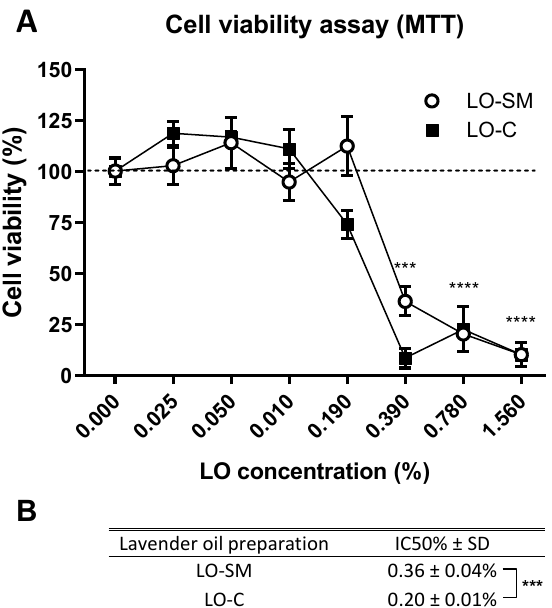
Figure 2. Cytotoxicity of tested lavender oils. ( A ) Cell viability assay (MTT) was performed after 24 h incubation of HaCaT cells with designated concentrations (v/v) of commercial or in-house preparation of lavender oil. Values are mean ± SD. Groups were compared to the control, and statistical analysis was performed using GraphPad Prism and build-in ANOVA test. p -values ≤ 0.05 were considered significant. ***— p ≤ 0.001; ****— p ≤ 0.0001. ( B ) IC50% values were interpolated as lavender oil concentration required for the 50% reduction in cell viability. The data represent mean ± SD between four replicates. Statistical significance was evaluated using a t -test. ***— p ≤ 0.001.